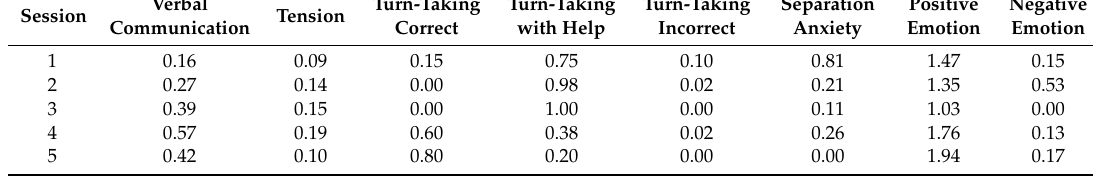
Table 5. Observations of social and communication skills during the therapy sessions.